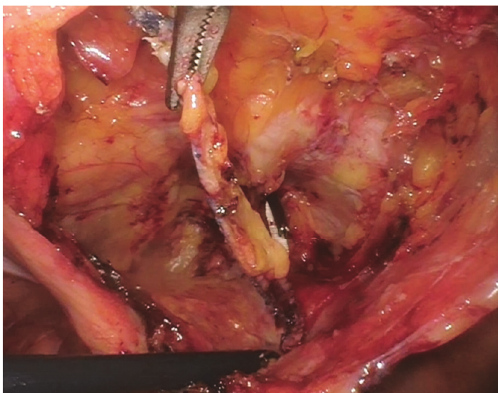
Figure 3: Arms of the mesh sling dissected away from the abdomi- nal wall near the pubic rami prior to vaginal removal. Permission to reprint from Miklos and